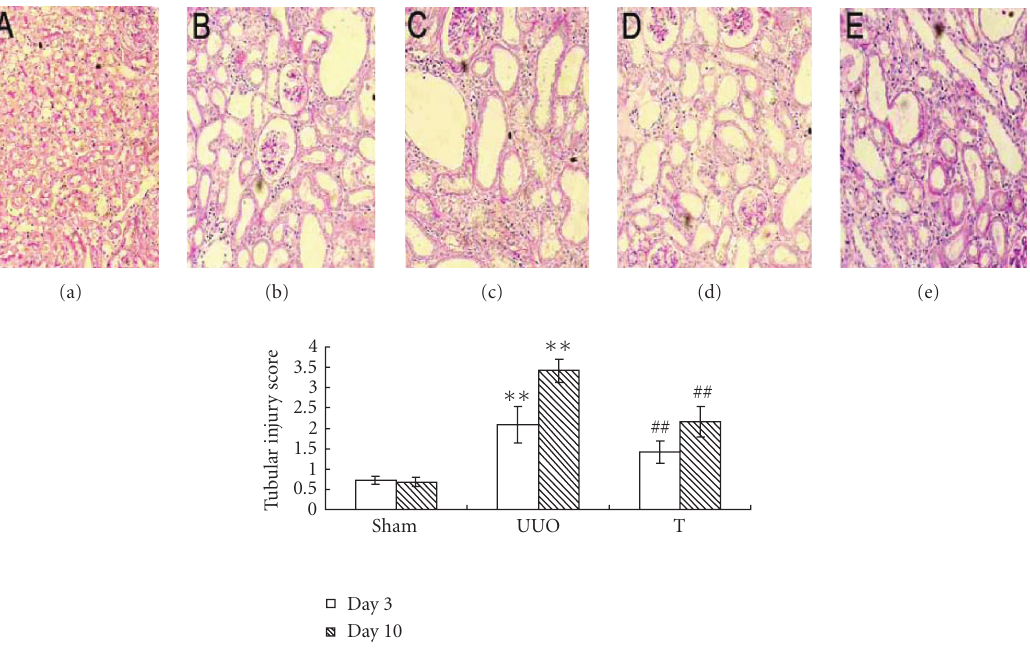
Figure 2: Tubular injury score at di ff erent time points in three groups ( × 100) . Sections were stained with PAS regent. Tubular lesions were graded according to the extent of cortical damage: (a) sham group, (b) UUO on day 3, (c) UUO on day 10, (d) treatment group on day 3, and (e) treatment group on day 10. ∗∗ : P < . 01 versus sham group of the same time point. ##: P < . 01 versus UUO group of the same time point.